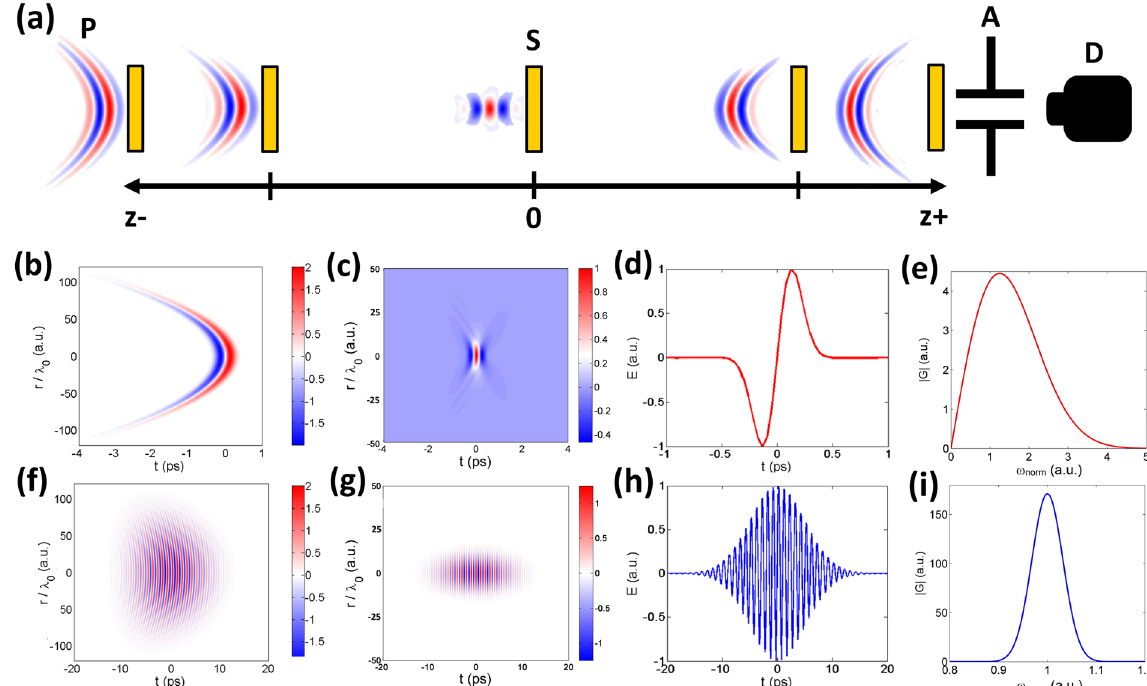
Figure 4. ( a ) Visual representation of the Z-scan method for the THz pulsed radiation propagating at the distance from z − to z + : for each position of the crystal the THz pulse was distributed through the air, the crystal itself and then further through the remaining distance in air to be finally captured at the detector, placed at z + . The distance of propagation corresponds to two focal lengths. Single-cycle ( b , c ) and multi-cycle ( f , g ) THz pulses representation at the input and in the focus correspondingly; ( d , h ) cross-sections of their electric field profiles correspondingly; ( e , i ) their